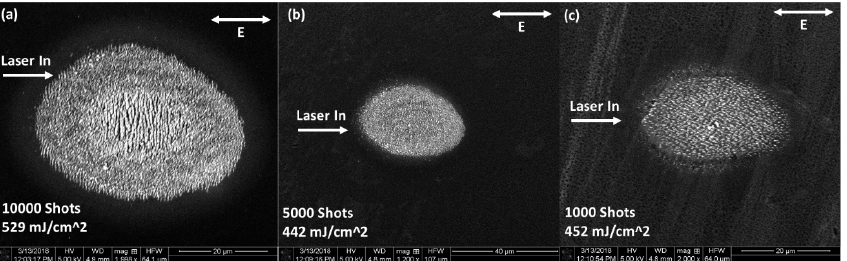
Figure 2. SEM micrographs of multi-pulse LID in silicon (111) with a high number of shots. From parts ( a – c ), the number of shots is decreasing while the fluence is mainly constant (up to fluctuations in the average pulse energy). Number of shots and fluence are located in the bottom left of the figure. In each figure, the input direction of the laser and polarization direction are indicated (as projected onto the sample